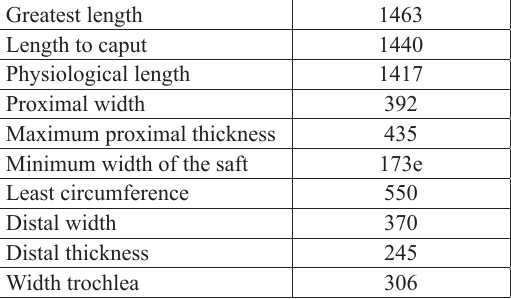
Table 10. Measurements (in mm) of the left humerus of the giant Mam- muthus trogontherii (MNHM PW1947/23) from Mosbach.